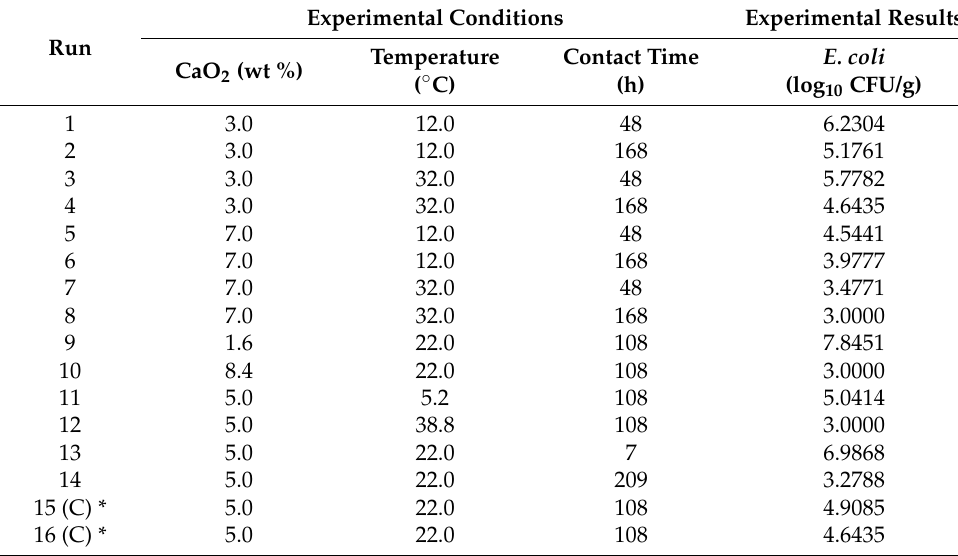
Table 2. Empirical conditions and results for the CCD/RSM